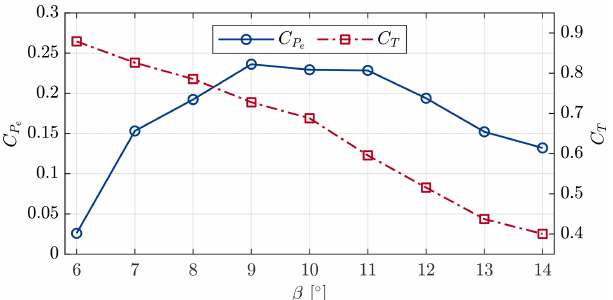
) and thrust ( C T ) e